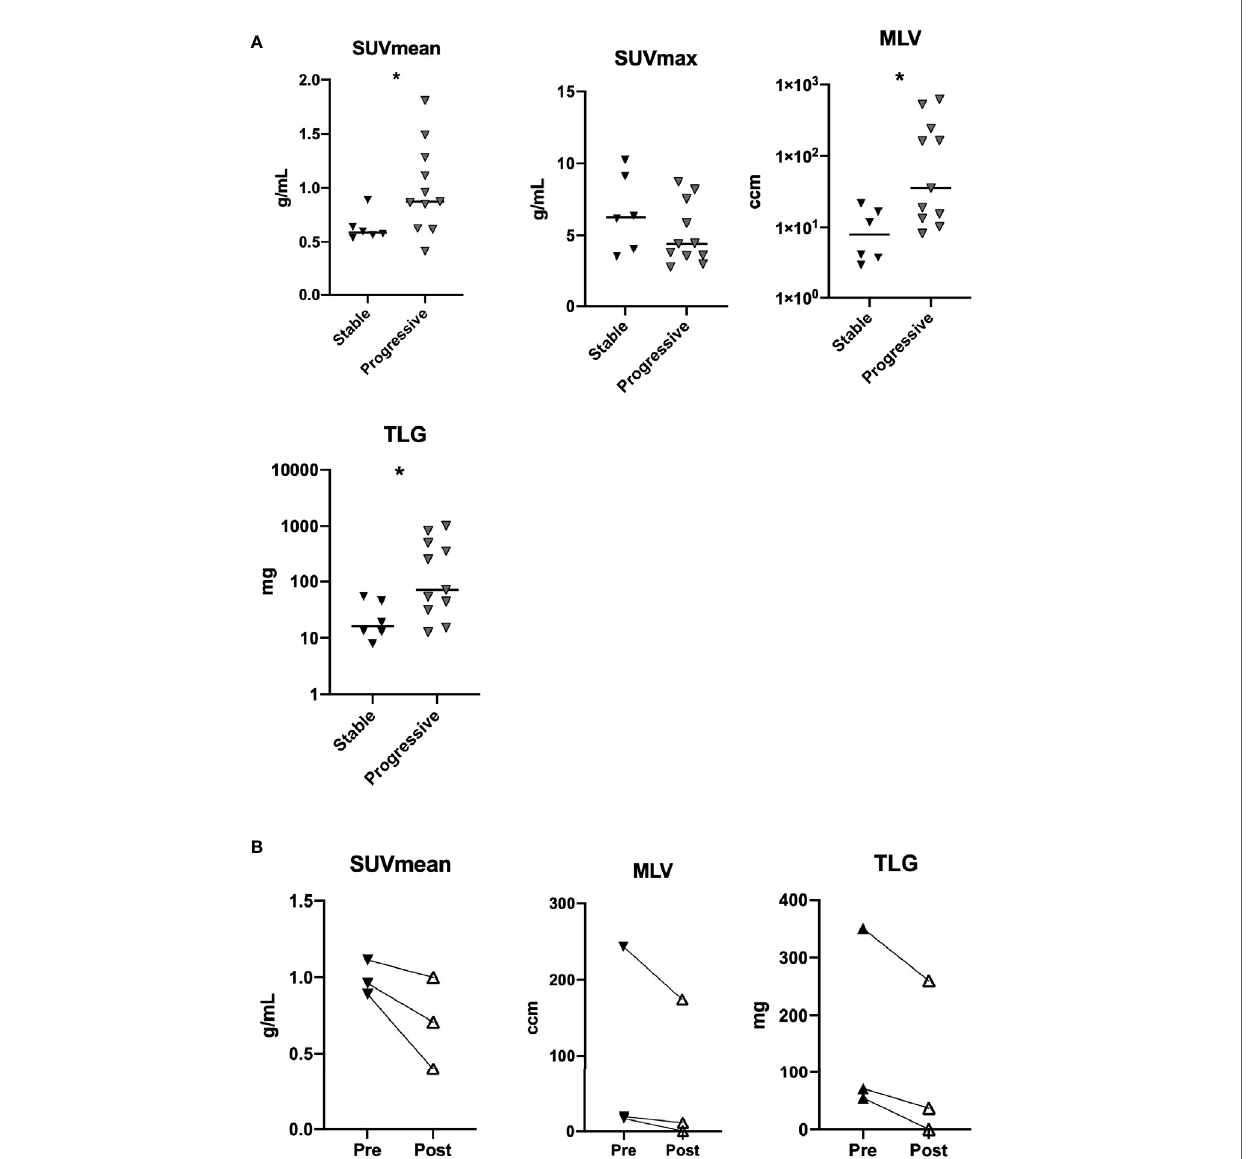
FIGURE 4 | FDG PET-CT in patients with stable and progressive disease as evaluated by SUVmean, SUVmax, metabolic lung volume (MLV), and total lung glycolysis (TLG) (n=17) (A) . SUVmean, MLV, and TLG in patients before and after treatment with rituximab (n=3) (B) . *p <